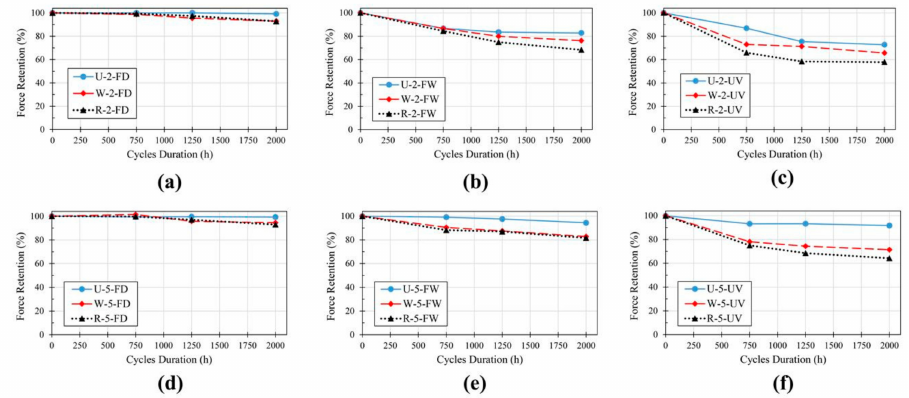
Figure 15. Comparison between the tensile strength reductions of GFRP laminates: ( a ) 2-mm laminate exposed to FD, ( b ) 2-mm laminate exposed to FW, ( c ) 2-mm laminate exposed to UV, ( d ) 5-mm laminate exposed to FD, ( e ) 5-mm laminate exposed to FW and ( f ) 5-mm laminate exposed to